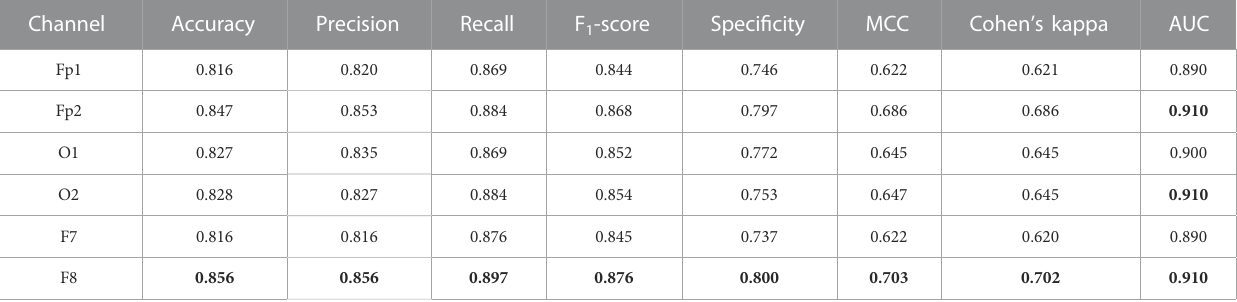
TABLE2 Confusionmatrix-basedperformanceevaluationmetricsoverallsubjects ’ datawithgloballyrankedfeaturesandBayesianoptimization-basedensemble classi fi er. Channel Accuracy Precision Recall F